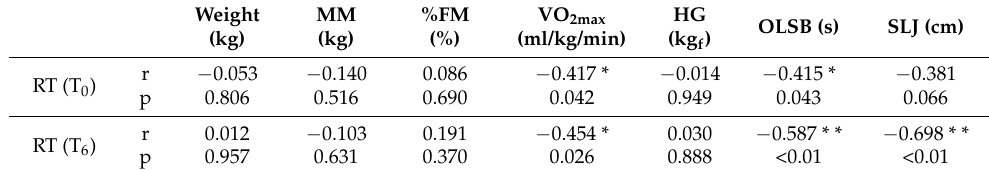
Table 3. Correlation between reaction time (RT) and physical fitness variables at T 0 and T 6